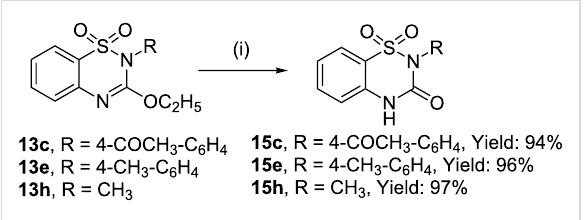
Scheme 4: Preparation of benzothiadiazine-3-one 1,1-dioxide deriva- tives by acid-catalyzed hydrolysis; reagents and conditions: 50 mg of compound 13 , 1 mL HCl, 4 mL ethanol, 80 °C, 4